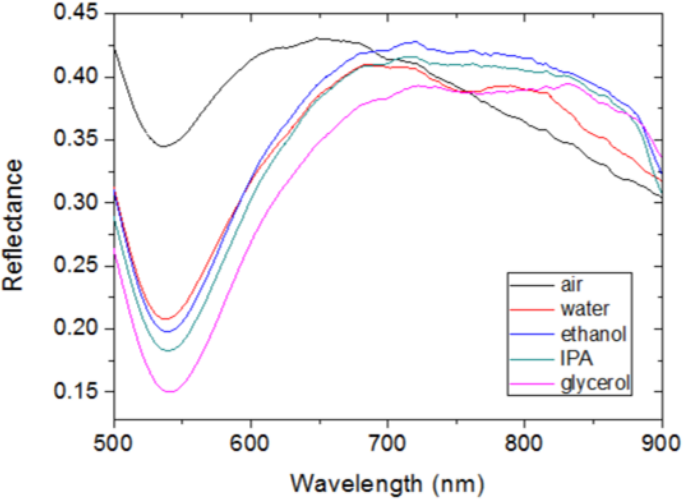
Figure 3. Spectral reflectance of the fabricated device when exposed to different fluids: air (black line), water (red line), ethanol (blue line), isopropanol (green line), and glycerol (magenta line).